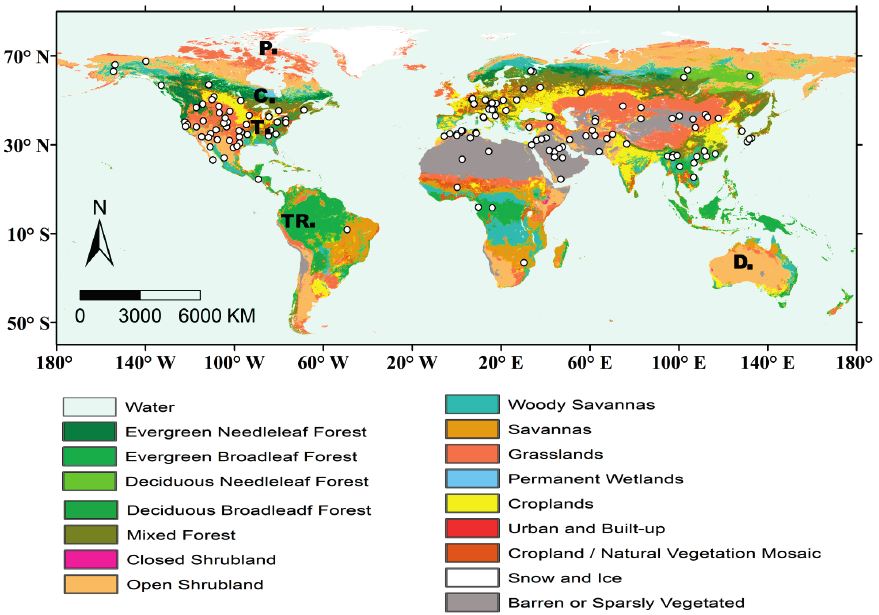
Figure 1. Global distribution of the WMO weather stations (white circles) used for validating the satellite surface air temperature estimates; the validation sites represent the global range of climate and land cover conditions represented by the MODIS IGBP global land cover map; The locations of five homogeneous test regions representing the major climate zones are represented by black squares and labeled as P, C, TR, D and T for Polar, Continental, Tropical, Dry, and Temperate Climate types, respectively. These test regions were used for partial validation of the sensor T b